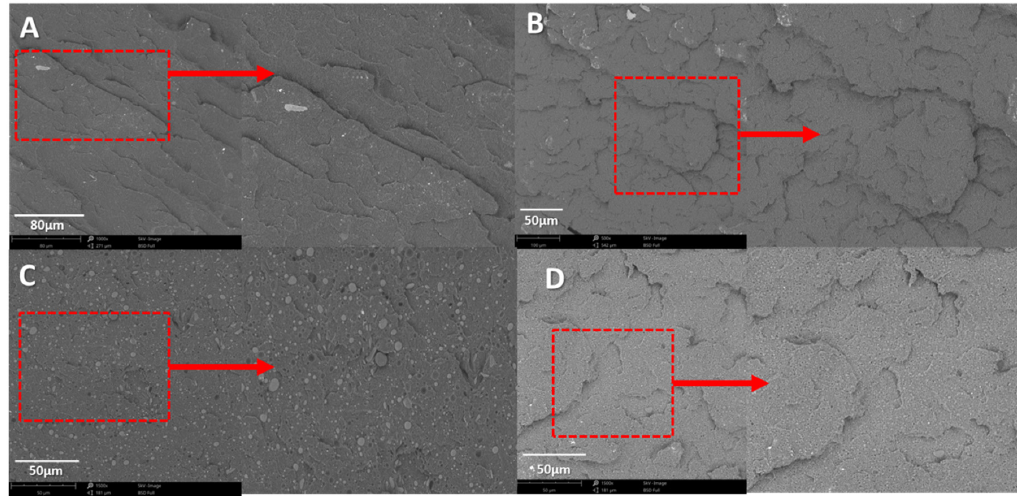
Figure 2. Fractured surface of ( A ) PP100 (1000×), ( B ) MPP100 (500×), ( C ) PP90/TPU10 (1500×), and ( D ) MPP90/TPU10 (1500×). and ( D ) MPP90/TPU10 (1500 ×